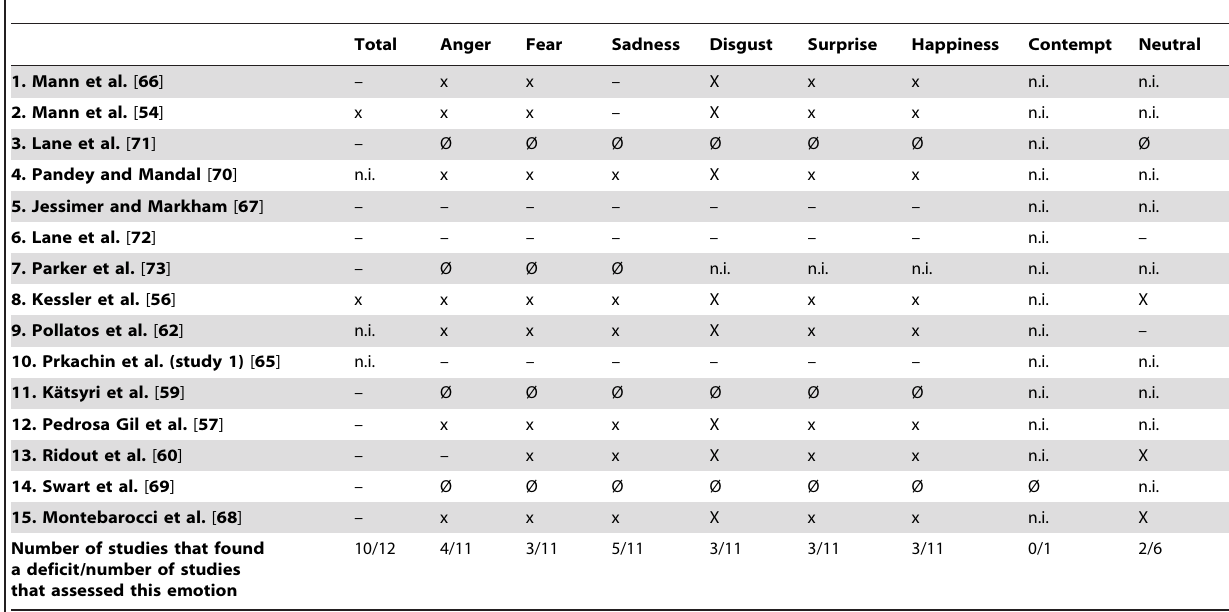
Table 2. Behavioural deficits among High Alexithymia Scorers to process emotional and neutral facial expressions, without controlling for confounding factors.